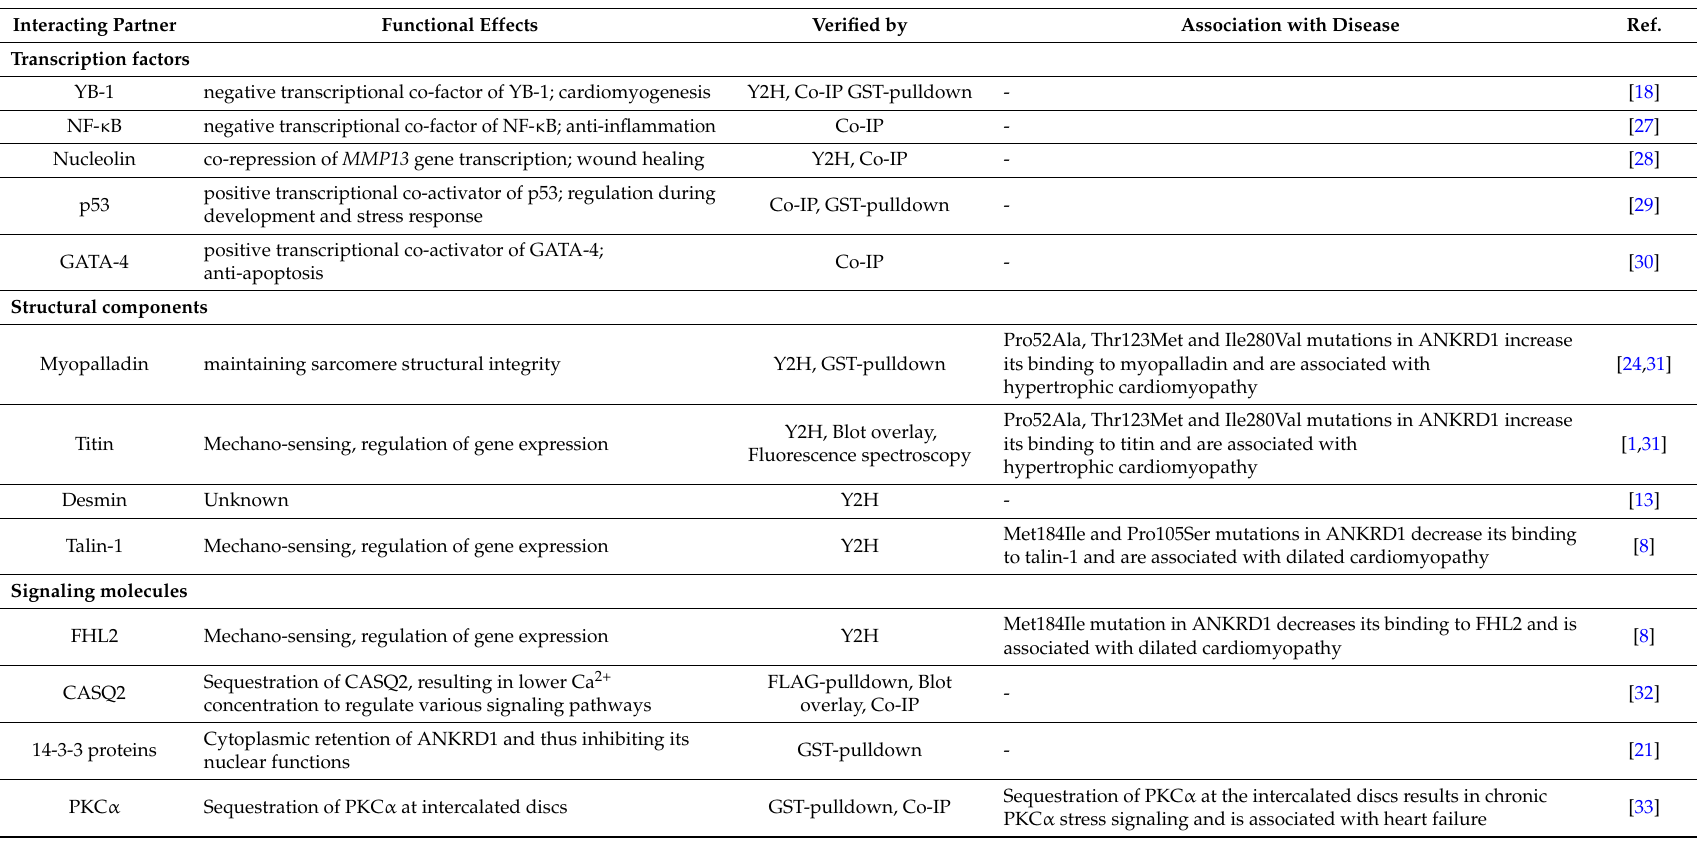
Table 1. Known interacting partners of